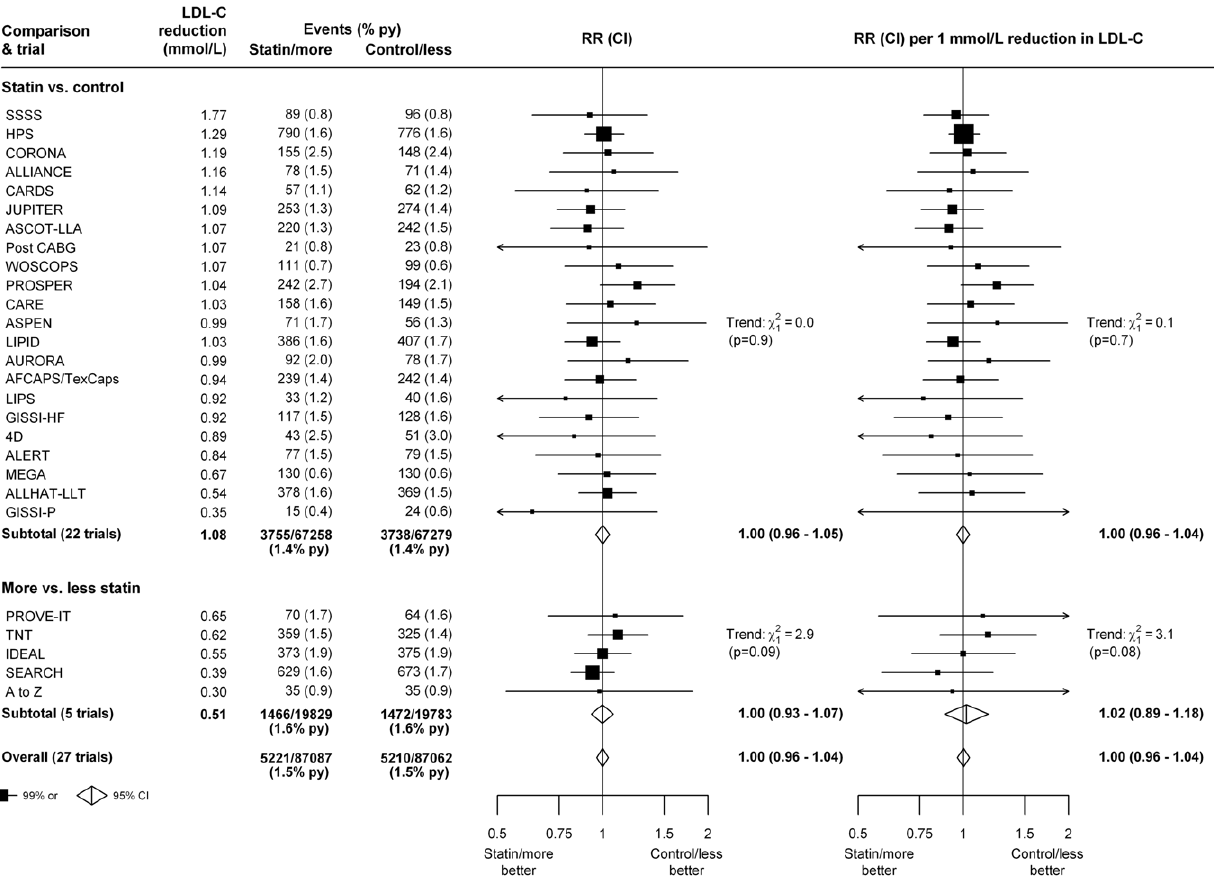
Figure 1. Effects of statin therapy on cancer incidence in each study. In the left panel, unweighted rate ratios (RRs) are plotted for each trial of the comparison of first event rates between randomly allocated treatment groups, along with their 99% confidence intervals (CIs). Trials are ordered according to the absolute reduction in LDL cholesterol at 1 year within each type of trial comparison (statin versus control and more versus less statin). In the right panel, rate ratios are weighted per 1 mmol/L LDL cholesterol difference at 1 year. Totals and subtotals, together with their 95% CIs, are indicated by open diamonds.